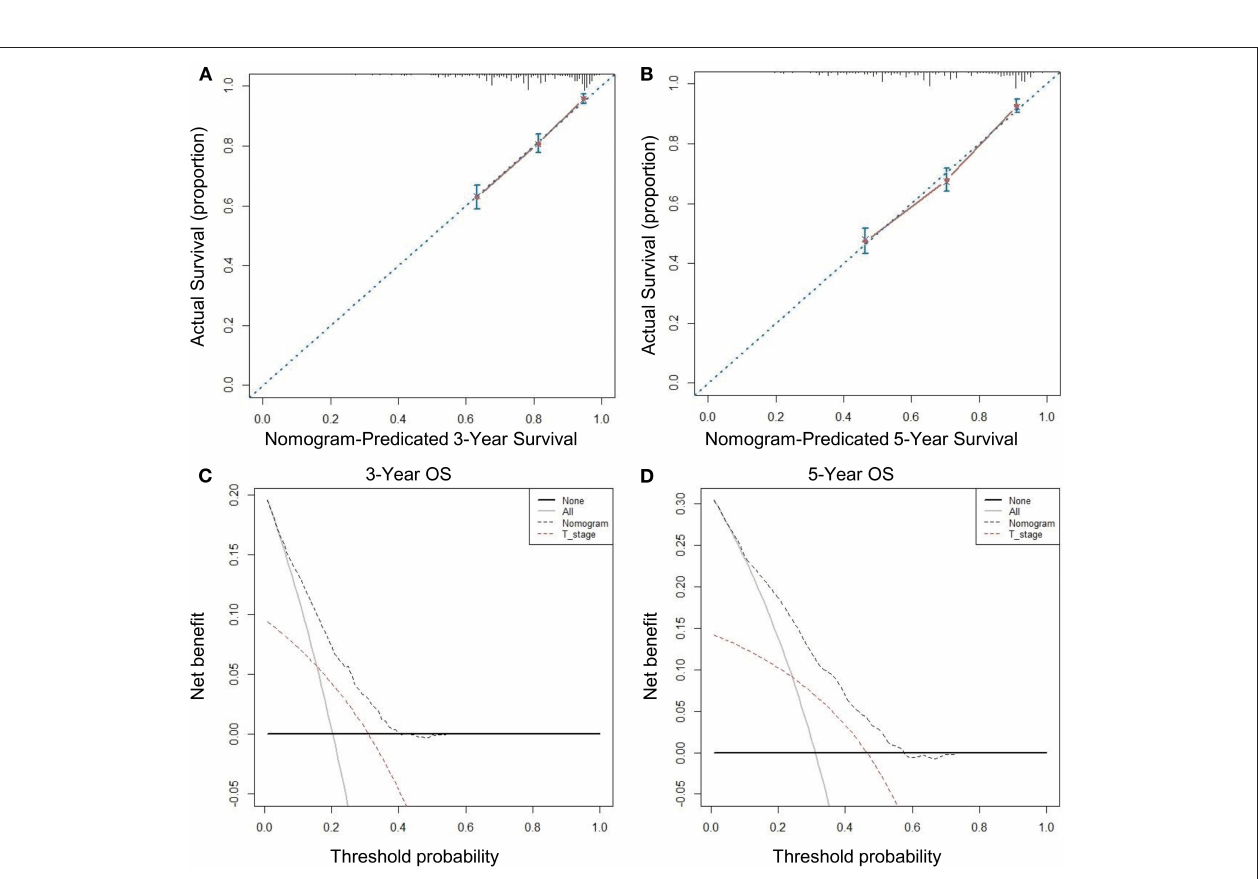
FIGURE 4 | Calibration curves and decision curve for OS prediction: (A) 3-year OS calibration curve in our cohort; (B) 5-year OS calibration curve in our cohort; (C) Nomogram was compared to the T stage in terms of 3-year OS in our decision curve analysis; (D) Nomogram was compared to the T stage in terms of 5-year OS in our decision curve